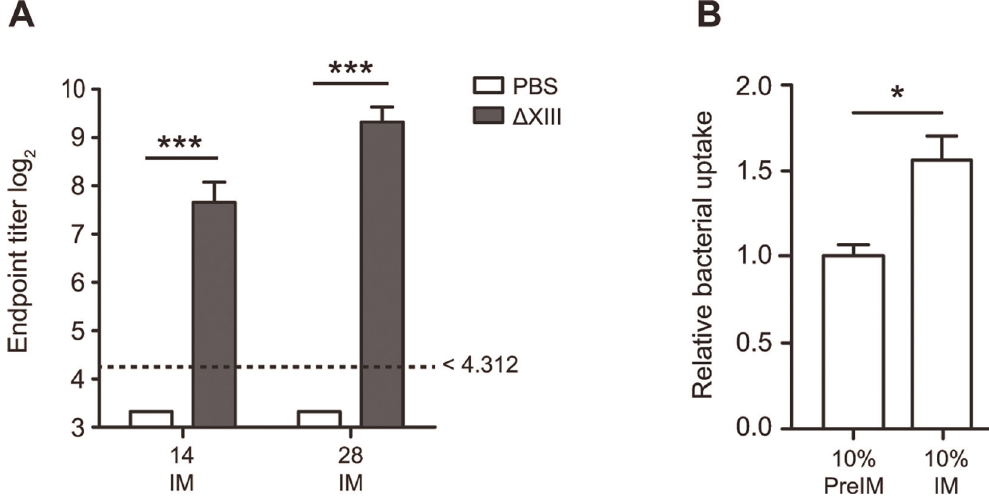
Fig 4. Humoral immune responses in mice immunized with Δ XIII strain. A) Sera obtained 14 and 28 days post-immunization from mice immunized with Δ XIII present significantly higher levels of IgG and IgM against heat- killed Δ XIII bacteria than sera from non immunized mice (control, treated with PBS) as determined by ELISA. No antibody to heat-killed Δ XIII bacteria was detected in sera from control mice (reciprocal titer, < 1:20). Error bars represent standard deviation between individual antibody titers. Statistical analysis was carried out using a two- way analysis of variance combined with the Bonferroni test. *** P < 0.001. B) Opsonization with immune serum enhances the uptake of Salmonella by murine macrophage cells. Opsonization and phagocytosis of S . Typhimurium143/09 by J774.2 macrophages was tested by counting the number of phagocytosed bacteria that had been previously mixed with 10% immune serum obtained 28 days post immunization (IM), pre-immune serum (PreIM) or PBS. The relative bacterial uptake of bacteria mixed with serum with respect to the uptake of bacteria suspended in PBS (value of 1.0) is represented. Results from duplicates on three separate days are shown. Statistical analysis was performed using the Mann – Whitney test. * P <